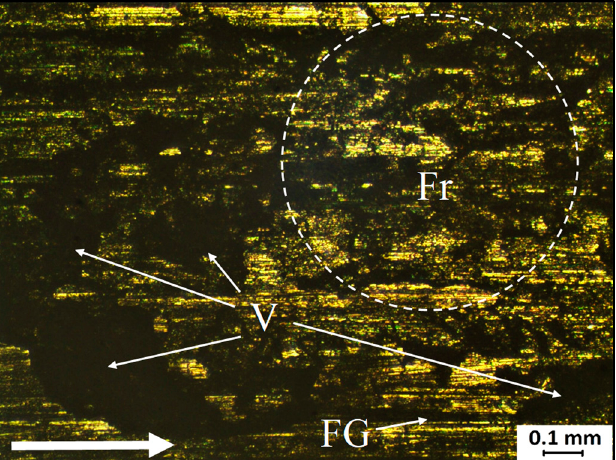
Figure 16. Wear morphology of recycled AA 6063 base metal after sliding distance test under starved